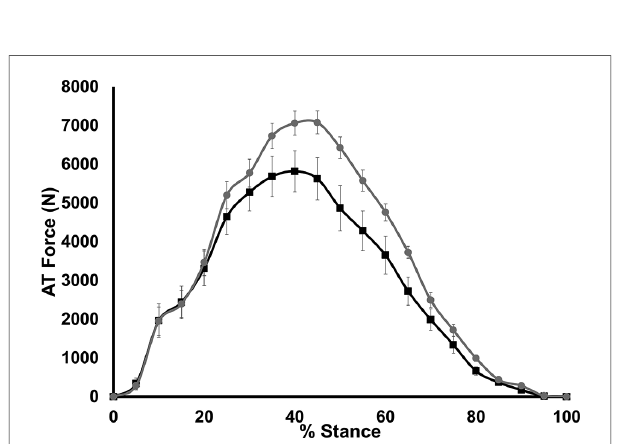
FIGURE 4 Time-normalized AT force over the stance phase of running. Values are presented as mean±SD. Grey circles represent the SHORT AT MA group, while black squares represent the LONG AT MA